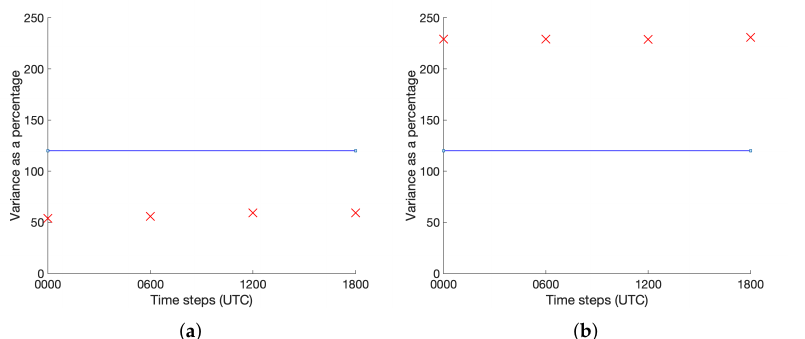
Figure 5. Variability of O 3 aCCFs expressed in terms of percentage variance at 250 hPa: ( a ) small variability (18 March 2016) and ( b ) large variability (1 March 2016). The blue line indicates the 120% line, and the samples are marked by red ‘ × ’ and correspond to 4 times (in UTC) of the day where data are available. Note that these samples represent averaged values over the chosen latitude and longitude range.